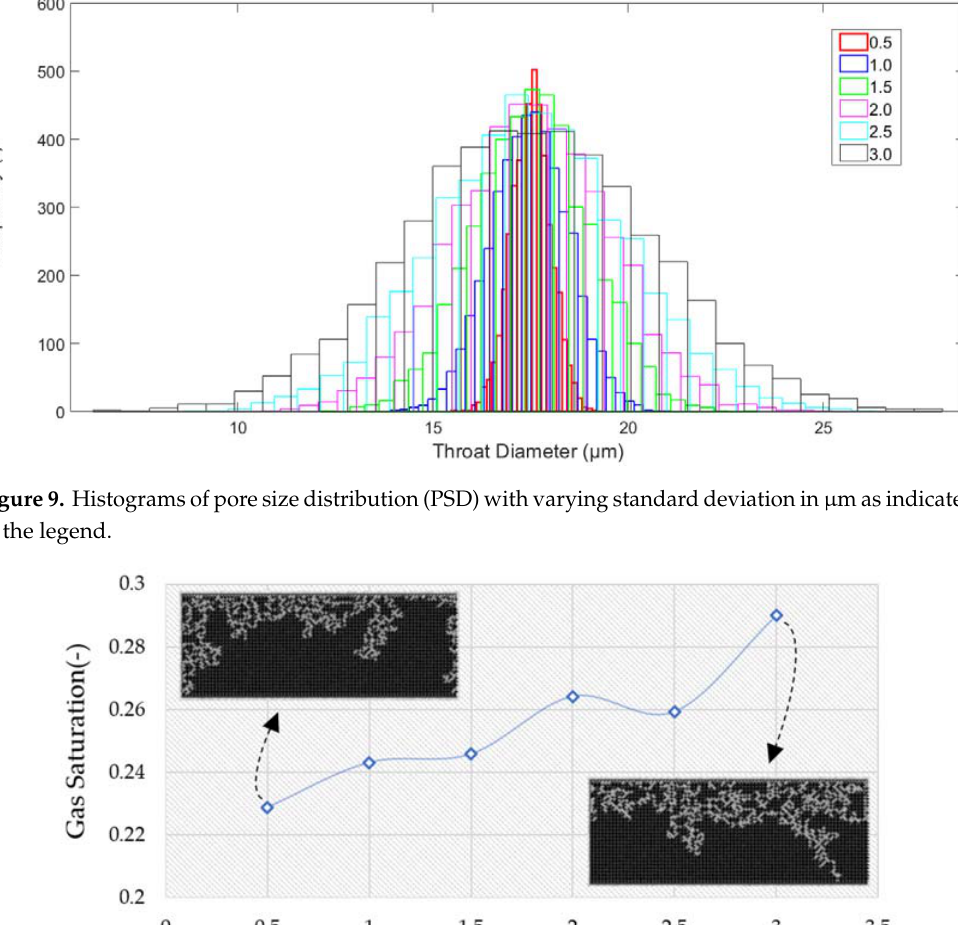
Figure 9. Histograms of pore size distribution (PSD) with varying standard deviation in μ m as indicated in the legend.